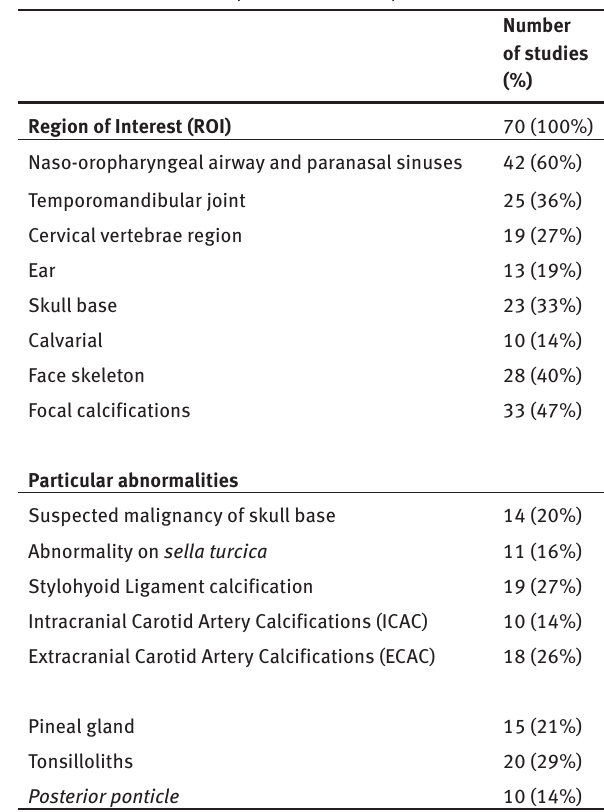
Table 2: Description of the retrospective studies included. The number and proportions of studies are given according to their year of publication, the region of interest explored, and some particular abnormalities reported by the authors.